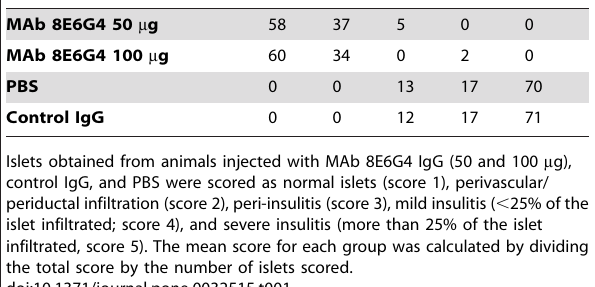
Table 1. Degree of insulitis in NOD mice.